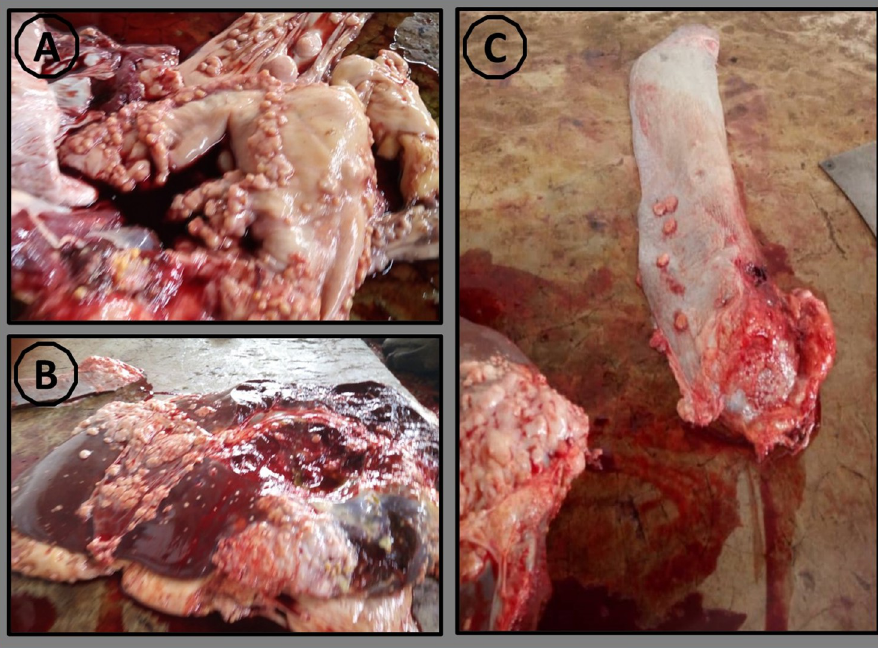
Fig 2. Granulomatous macro lesions sampled from selected cattle organs: (A) granulated lesion from the lung (B) granulated lesion from the liver (C) granulated lesion from the